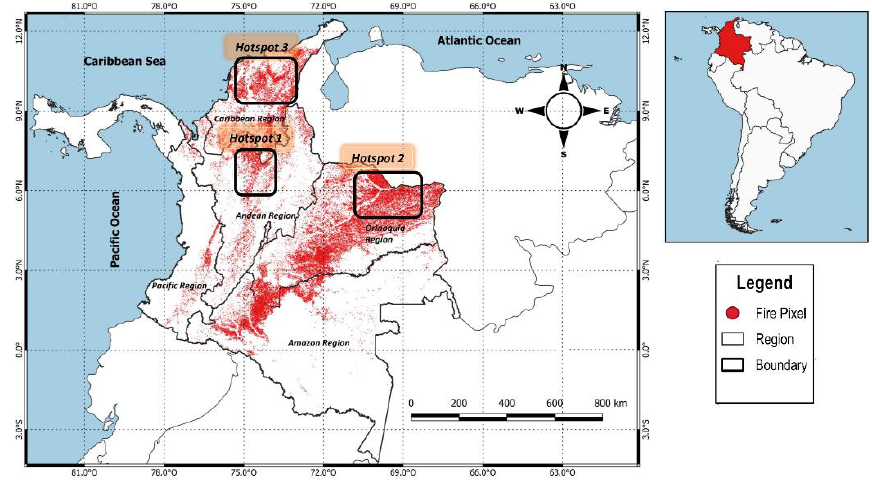
Figure 1. Map of the spatial distribution of active fires in Colombia, showing main fire hotspots. The annual cycle of rains in Colombia obeys three types of regimes: unimodal (a wet season and a dry season), bimodal (two wet seasons and two dry), and mixed (a combi- nation of both). In general, the unimodal regime prevails over the bimodal and the mixed. The unimodal regime occurs in the south and center of the Caribbean region and in the north of the Andean region, in the Orinoco and Amazon regions, and in the north of the Pacific region. The bimodal and mixed regimes occur mainly in the Andean region and the north of the Caribbean region, in La Guajira. The Pacific region observes the occurrence of the four-rainfall regime [33].